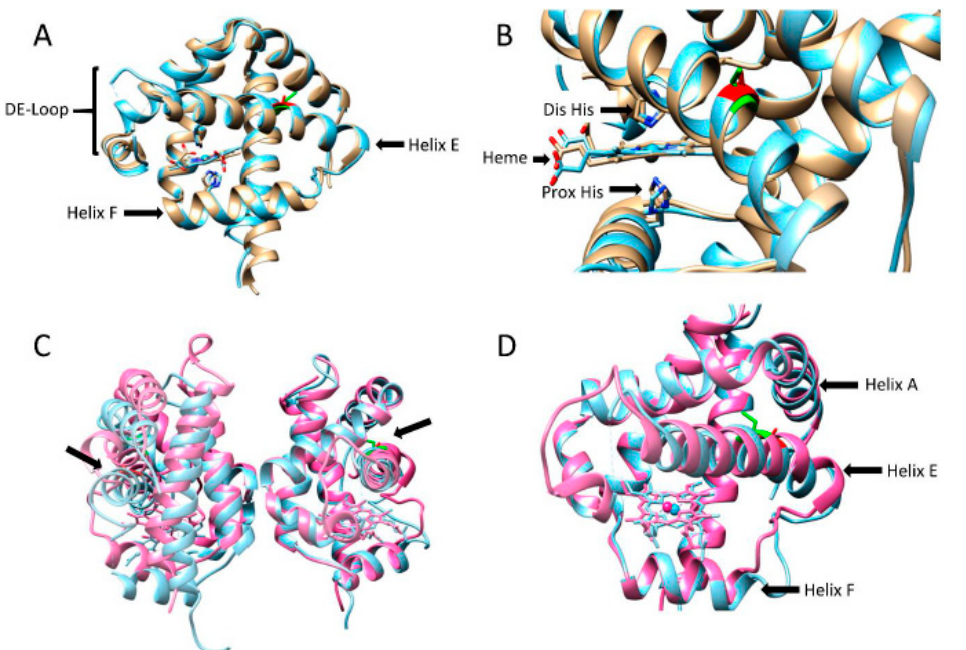
Figure 2. Crystal structure comparison of BvPgb 1.2 WT, Cys86Ala, and Barley Hb. ( A ) Structure comparison between BvPgb 1.2 WT (gray) and Cys86Ala (light blue), highlighting helices E and F in addition to the missing DE-loop. ( B ) Zoomed-in view of the heme-group, displaying the heme group, proximal and distal histidinem and the orientation of the cysteine (green) and alanine (red) in the WT and mutant, respectively. ( C , D ) Comparison between Cys86Ala (light blue) and Barley Hb (PDBID: 2OIF) (pink), showing orientation of the cysteine in Barley Hb (green) and BvPgb 1.2 Cys86Ala (red).